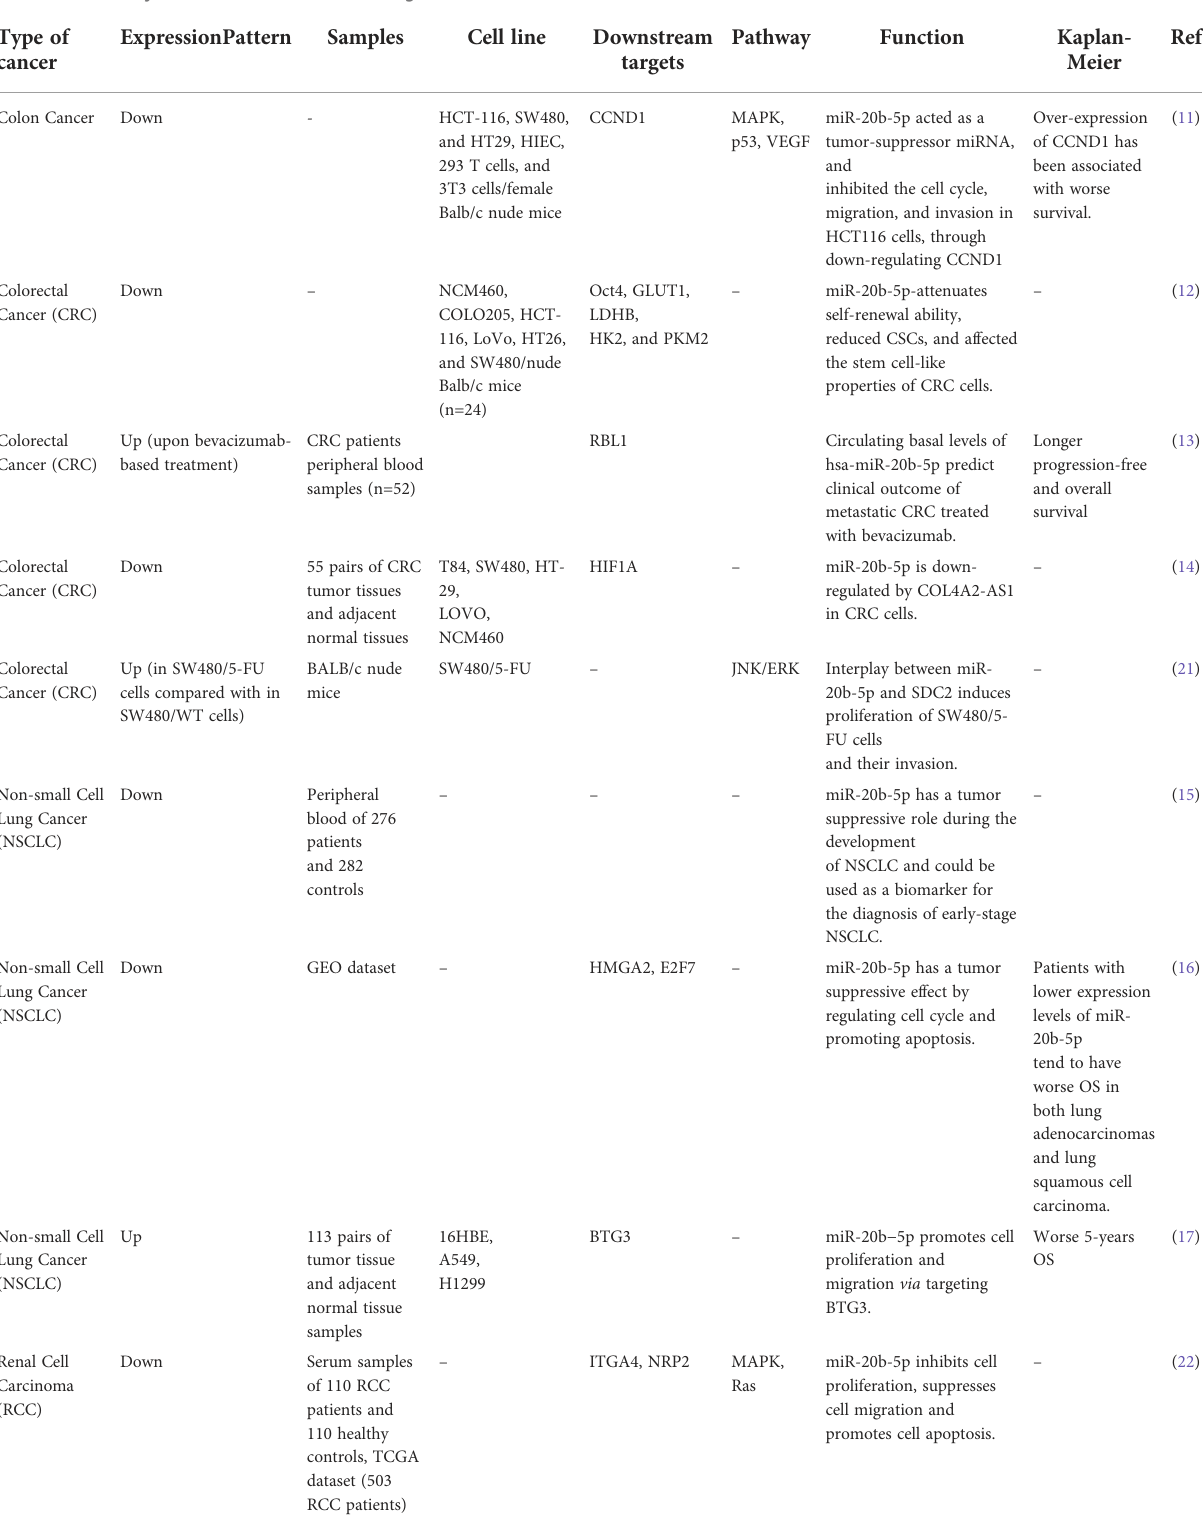
TABLE 1 Summary of the role of miR-20b in malignant